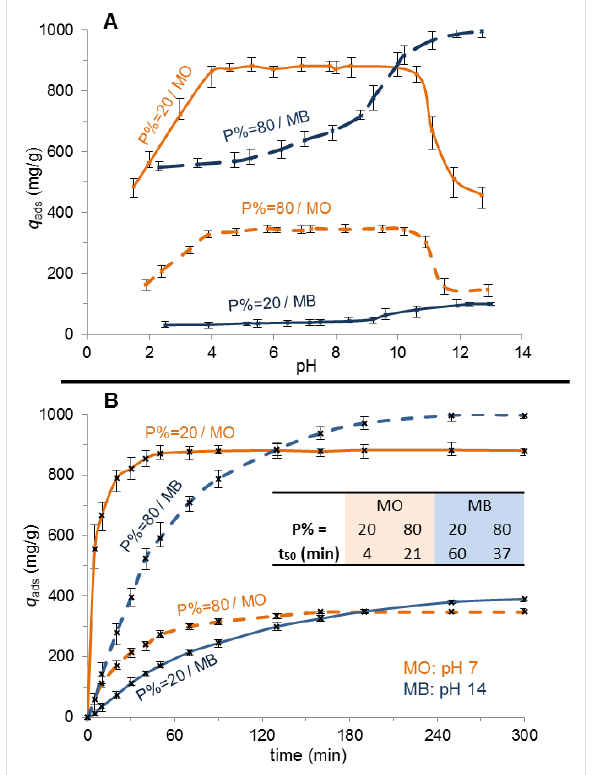
Figure 2: A) pH Values at which NP-PEIP20 and NP-PEIP80 adsorb a maximum amount of dye. MO is better adsorbed in the range of pH from 4 to 10. P% does not impact the pH range but the amount of re- moved dye. For MB, the higher the P% is, the better the extractions are, regardless of the pH value. Maximum amounts are removed at basic pHs. B) Adsorption of MO is faster than that of MB, regardless of the percentage of phosphonate